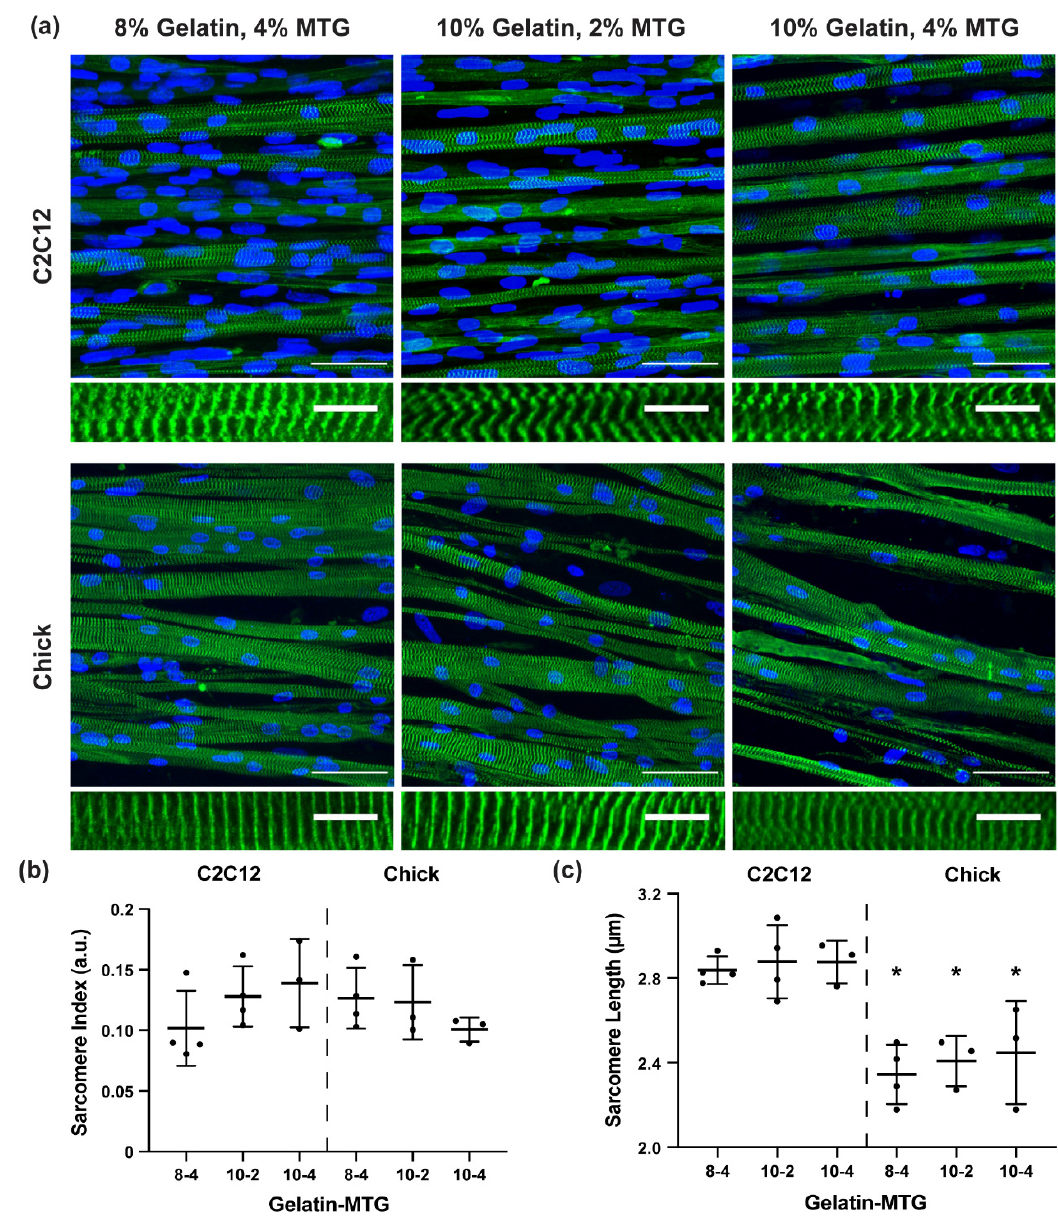
Figure 7. ( a ) Representative images of C2C12 and chick tissues stained for α -actinin (green) and DAPI (blue) on micromolded gelatin hydrogels with the indicated formulations. Scale bar top: 50 µ m, bottom: 10 µ m. Sarcomere index ( b ) and sarcomere length ( c ) for C2C12 and chick tissues cultured on micromolded gelatin hydrogels with the indicated formulations. Bars indicate standard deviation, n = 3–4. * indicates p < 0.05 between C2C12 and chick tissues cultured on the same gelatin-MTG formulation based on student’s t -test.